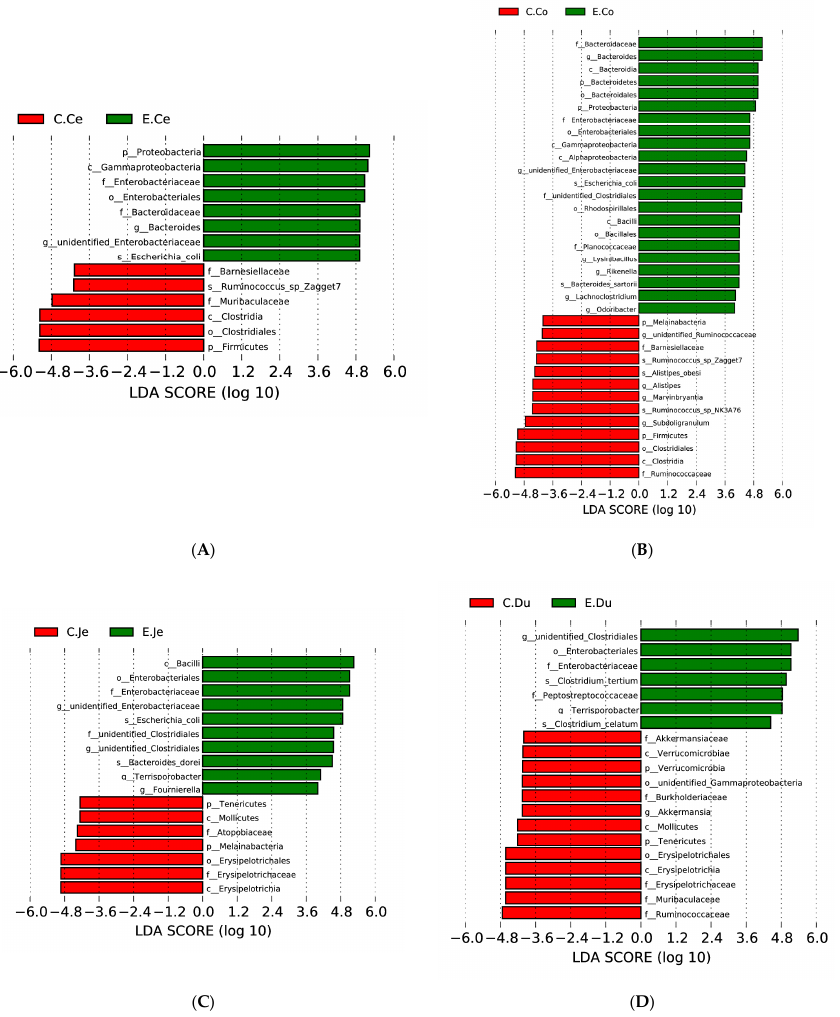
Figure 6. Linear discriminant analysis (LDA) effect size analysis of FIS in Hyplus rabbits (Con, n = 6; Dia, n = 6). LDA score ≥ 4 demonstates a biomarker with statistical differences between Con and Dia groups. ( A ) shows the differentially expressed flora in the cecum of the Dia group and the cecum of the Con group; ( B ) shows the differentially expressed flora in the colon of the Dia group and the colon of the Con group; ( C ) shows the differentially expressed flora in the jejunum of the Dia group and the jejunum of the Con group; ( D ) shows the differentially expressed flora in the duodenum of the Dia group and the duodenum of the Con group; p: phylum, c: class, o:order, f:family; g: genus; s:species. C, control group (Con, n = 6); E, diarrhea group (Dia, n = 6); Co, colon; Ce, cecum; Du, duodenum; Je,